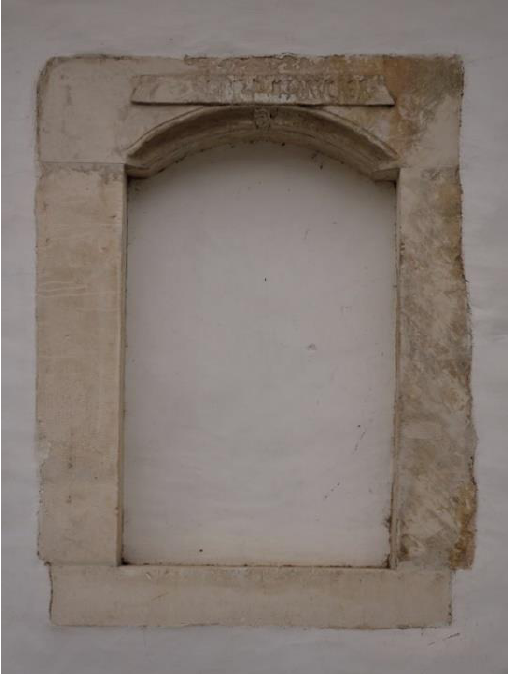
Figure 4. Built-in window on the northern façade with the dedicatory inscription of the Druckher couple, who purchased the building after the expulsion of the Jews in 1497 and turned it into All Saints Church. Photo: Janez Premk.